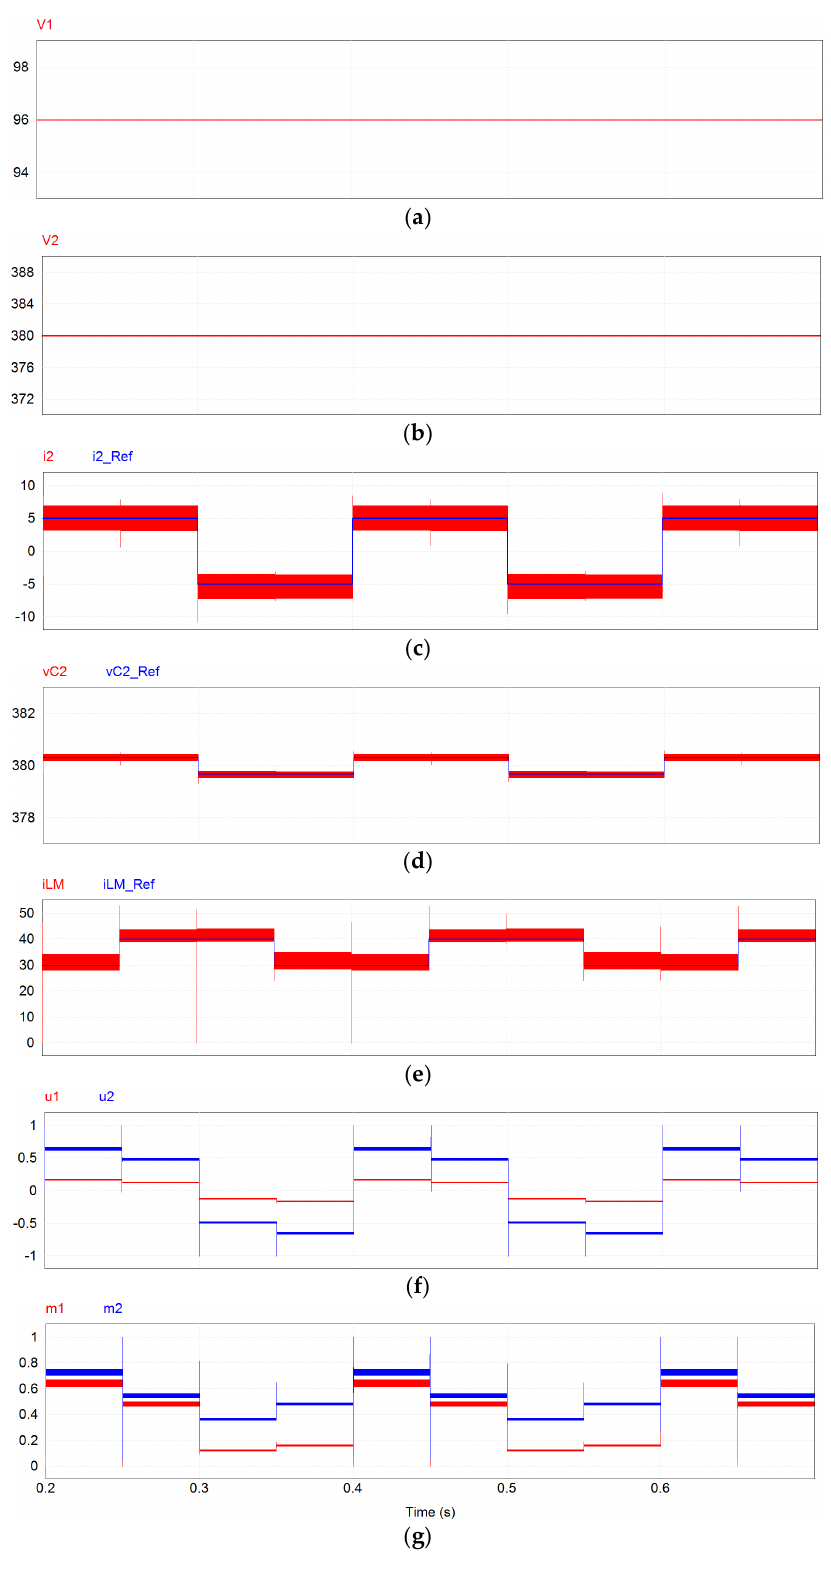
Figure 12. Waveforms for the tri-state buck–boost control with state feedback linearization. ( a ) Voltage at Bus 1 (in V), ( b ) voltage at Bus 2 (in V), ( c ) reference and output current (in A), ( d ) reference and output capacitor voltage (in V), ( e ) reference and inductor current (in A), ( f ) non-linear control variables, ( g ) PWM modulation